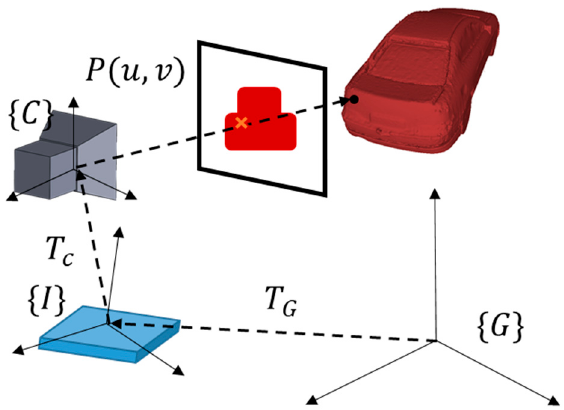
Figure 3. Geometric relation between camera and IMU (Inertial Measurement Unit) sensor.